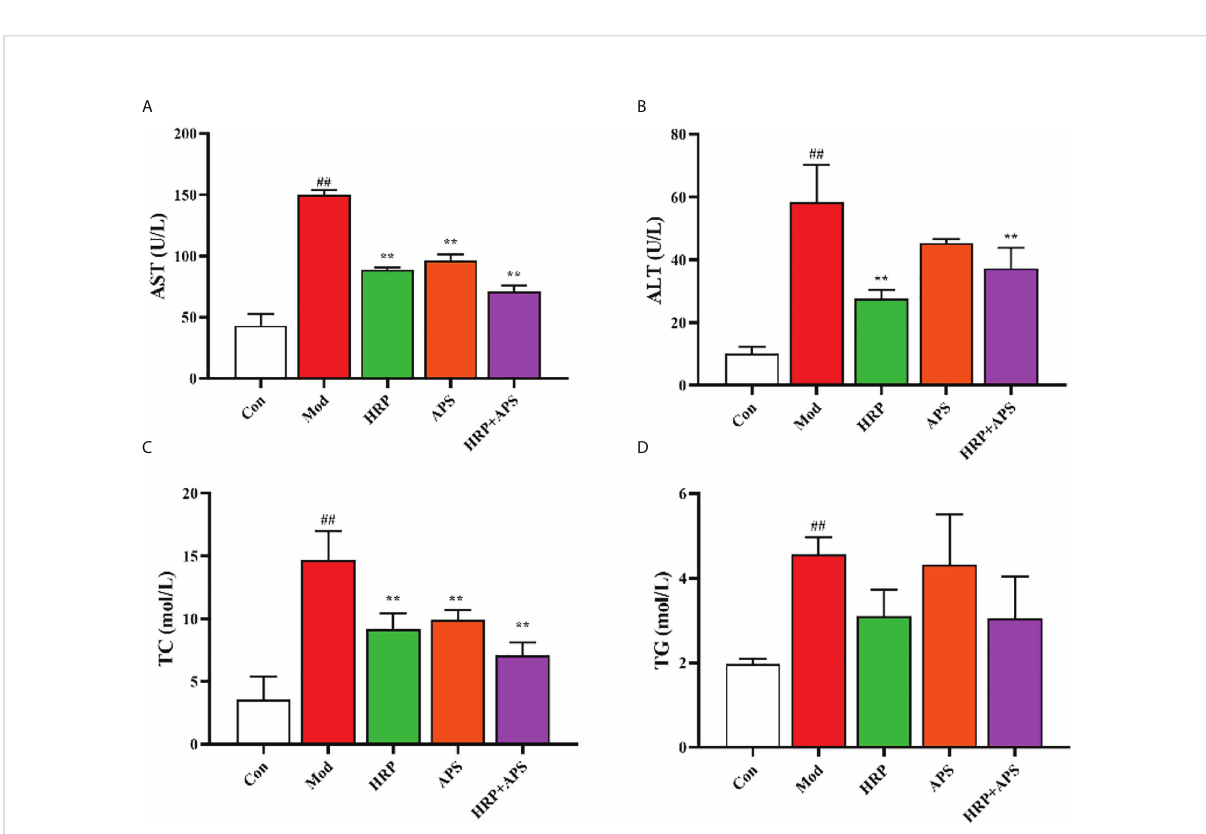
FIGURE 3 The effects of HRP, APS and the combination of HRP and APS on serum biochemical indexes of AFLD mice. (A) Serum AST. (B) Serum ALT. (C) Serum TC. (D) Serum TG. Data are presented as mean ± SD (n = 6). ## P < 0.01 vs. Con; ** P < 0.01 vs. Mod.